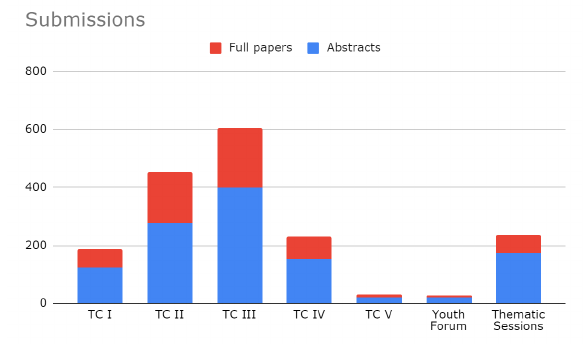
Figure 2. Submitted papers per